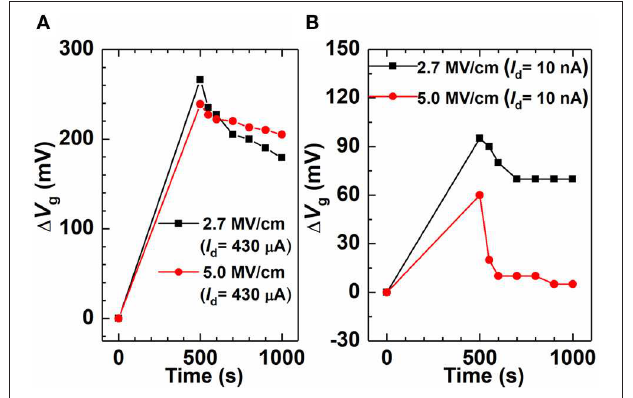
FIGURE 6 | Time-dependence of 1 V g extracted in (A) I d = 430 µ A and (B) I d = 10 nA at a constant field strength of E = 2.7 and E = 5.0 MV/cm in stress (0 and 500s) and recovery (500–1,000s) phases.